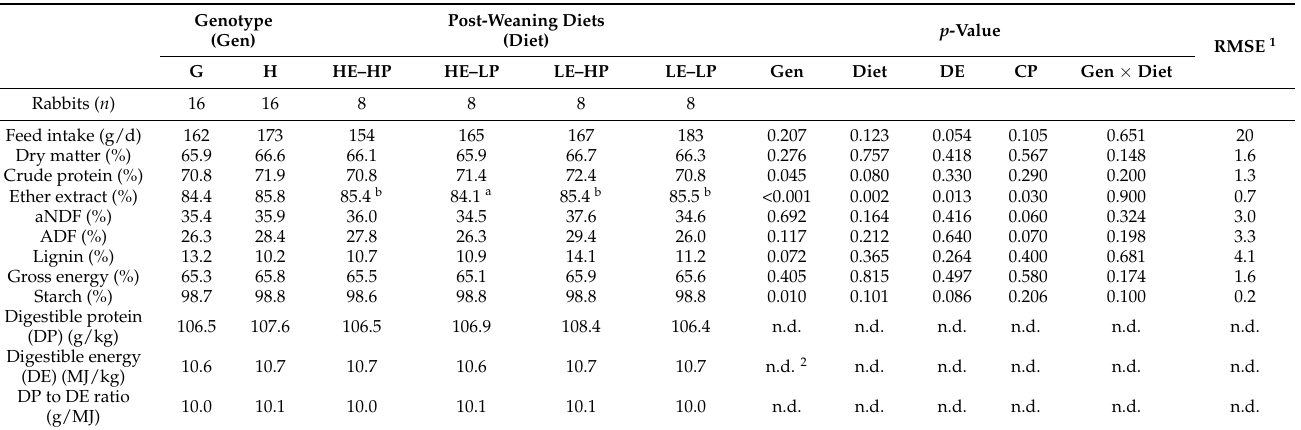
Table 4. Faecal apparent digestibility of dietary components and nutritive value (as-fed basis) of the fattening diet (digestibility trial from 72 to 76 days of age).